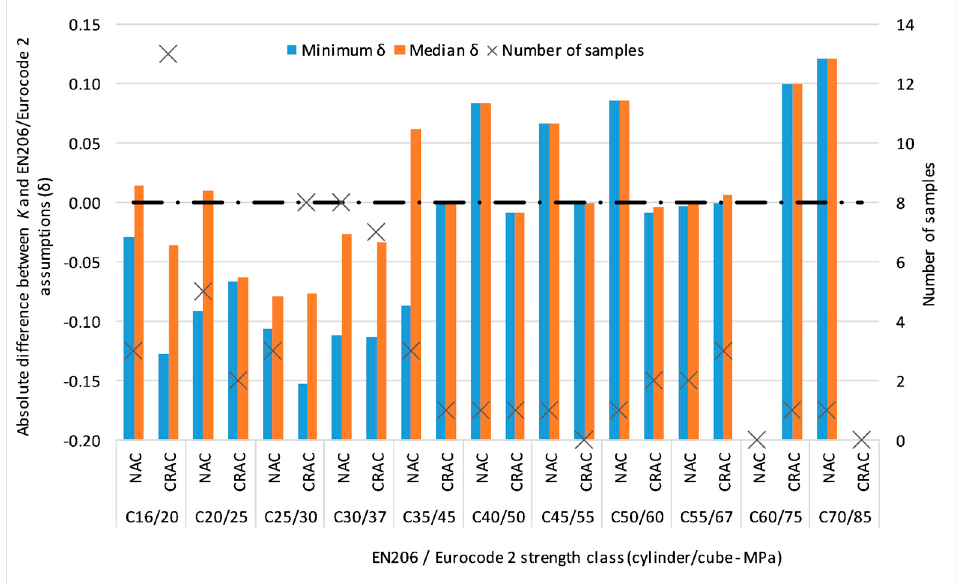
Figure 2. Absolute difference experimental data versus EN206/Eurocode 2 assumptions.